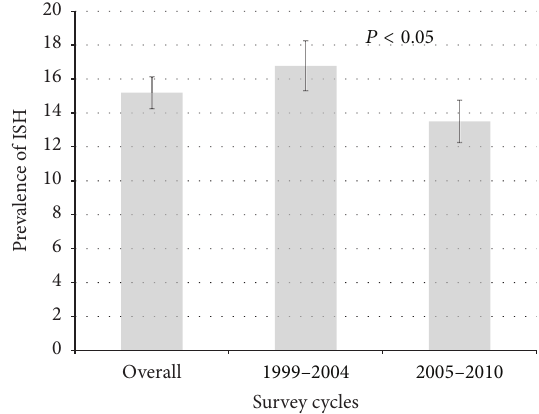
Figure 1: Prevalence and 95% confidence intervals of isolated sys- tolic hypertension by survey cycles in NHANES 1999–2010, USA. (The prevalence of isolated systolic hypertension was age-adjusted by direct standardization to the 2000 projected US population. NHANES, National Health and Nutrition Examination Survey; ISH, isolated systolic hypertension. 𝑃 < 0.05 indicates the significant dif- ference in the prevalence of ISH between 1999–2004 and 2005–